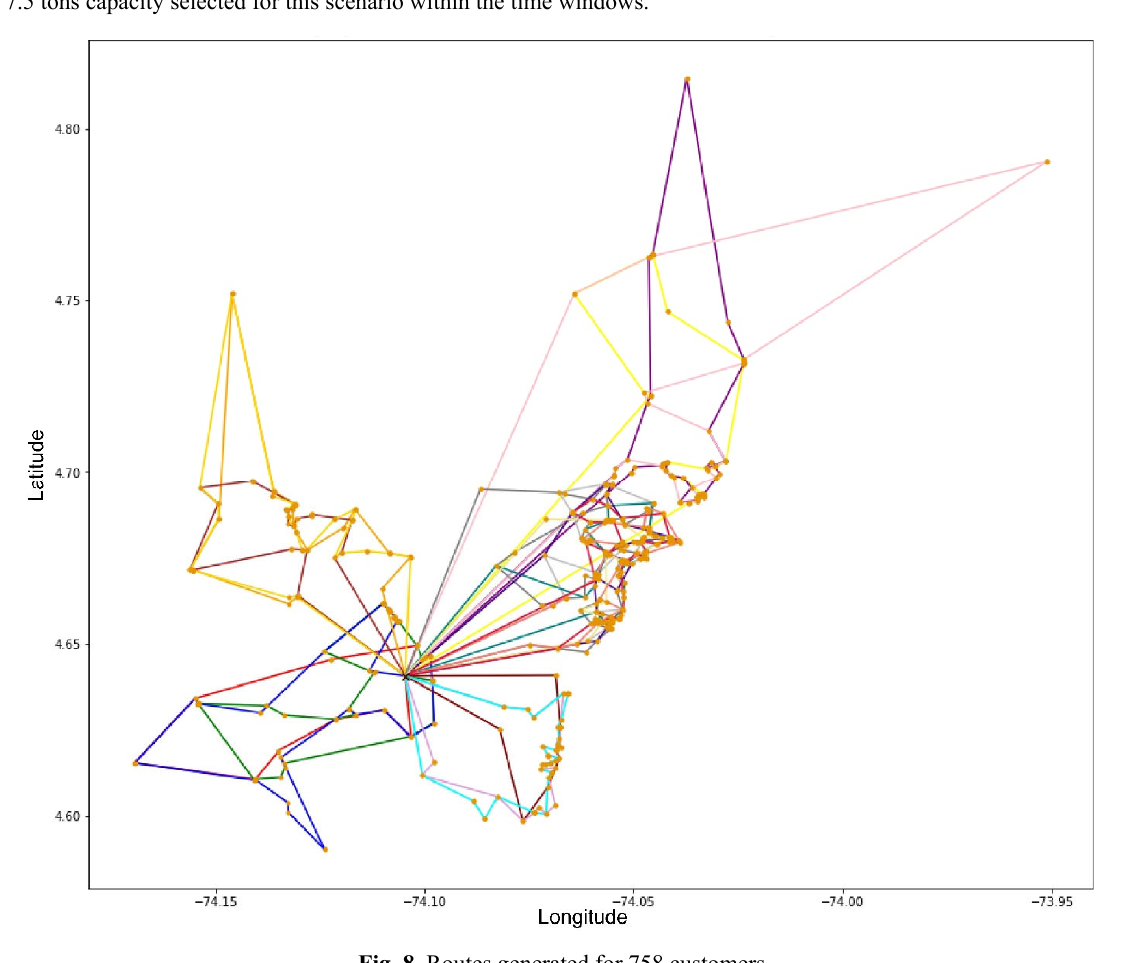
Fig. 8 . Routes generated for 758